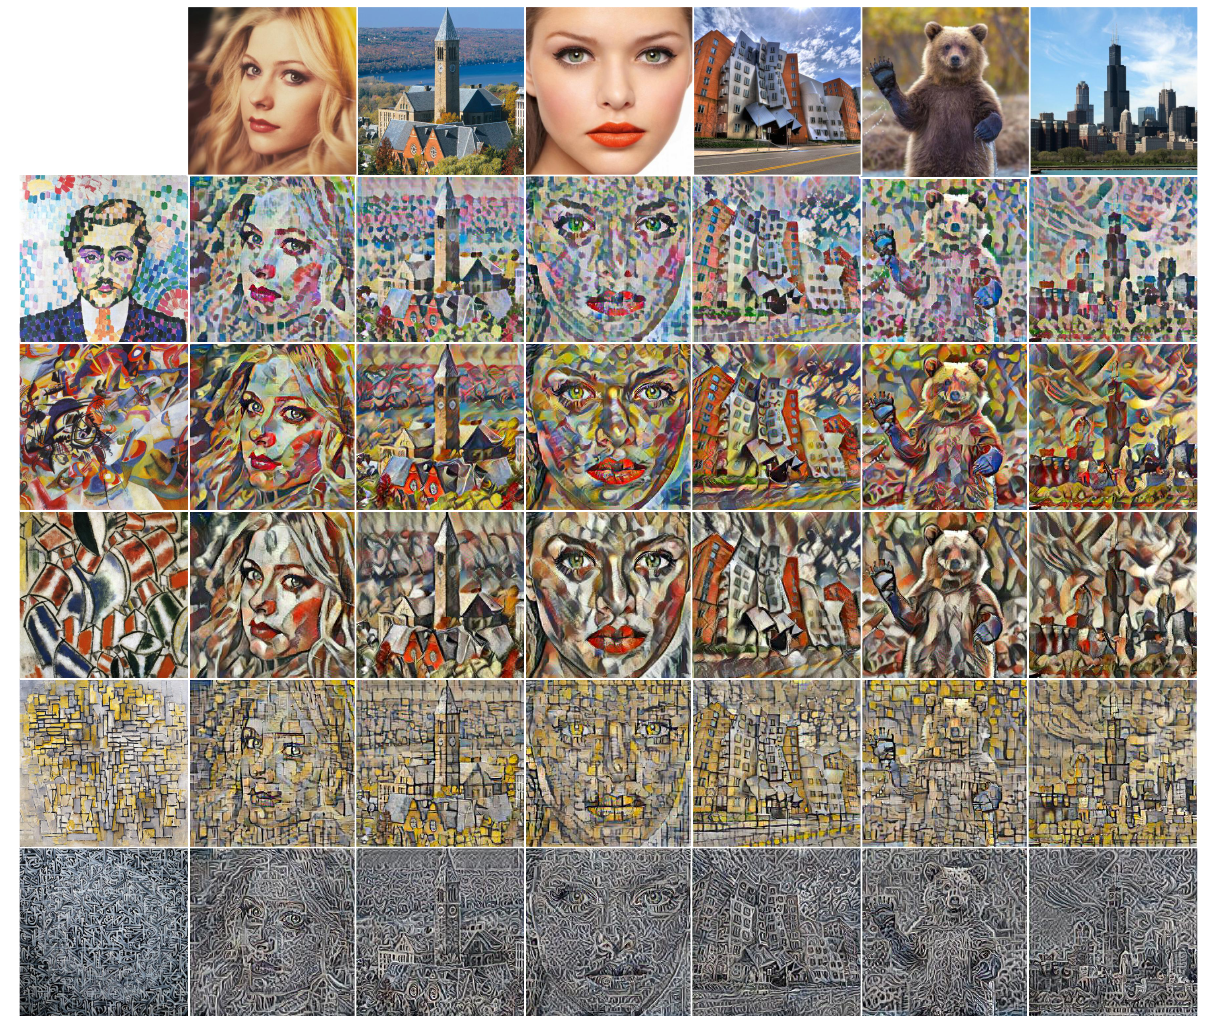
Figure 9. Additional result images of ours-inter based on the VGG16 feature network: The first row and column are the target content image and target style image, respectively, and the target images were not used during network